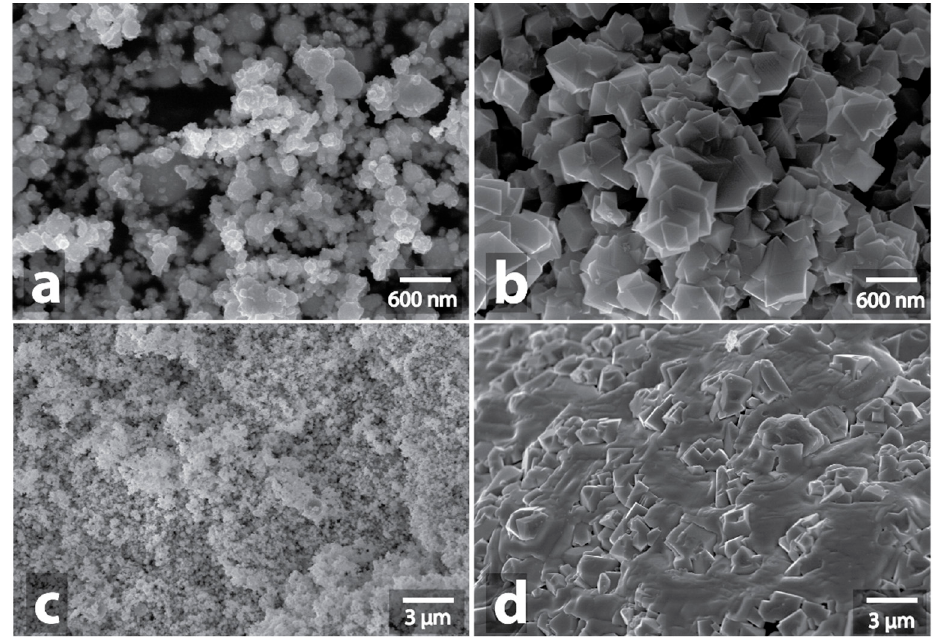
Figure 6. SEM image of initial Fe/C powder ( a ) and SEM image of Fe/C powder after MW-treatment ( b ), initial Mo-Fe-C powder ( c ) and SEM image of Mo-Fe-C powder after MW-treatment ( d ).